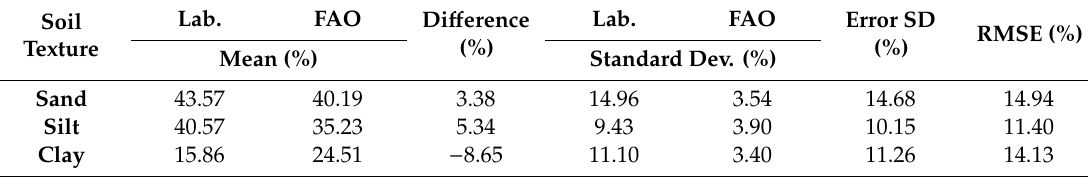
Table 7. Comparison of the Food and Agriculture Organization (FAO) with laboratory measurements of soil texture